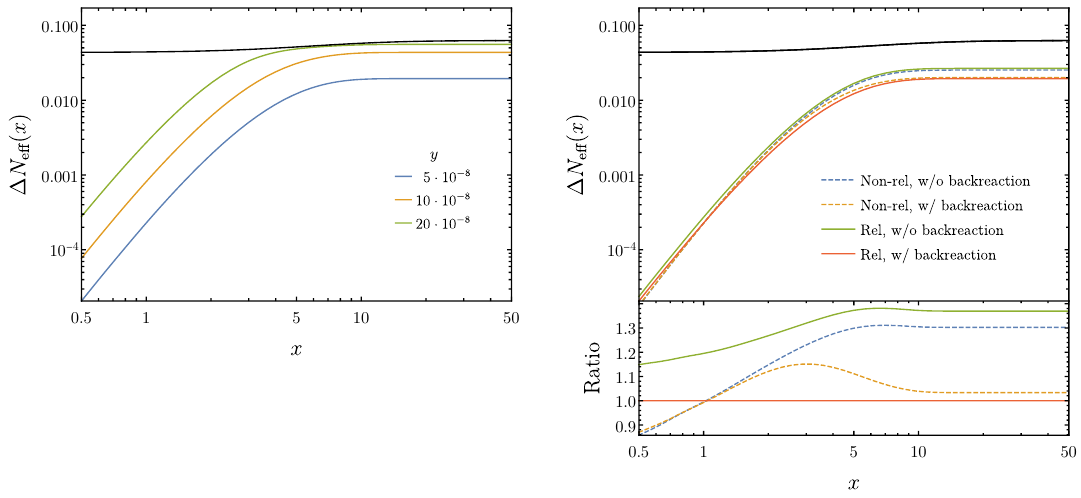
Figure 1 . Shift in the effective number of relativistic species as defined in eq. (2.5) as a function of time for a benchmark mass value of m = 300 GeV . The left panel shows how increasing the B coupling increases ∆ N , but the increase becomes milder for large couplings due to the backreaction eff effect. The right panel illustrates the importance of the various effects included in our analysis compared to simpler approximations (non-relativistic decays, no